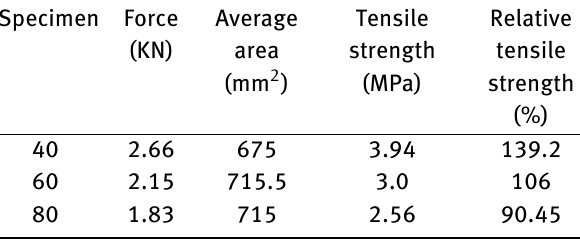
Table 16: Tensile strength of geopolymer mortar